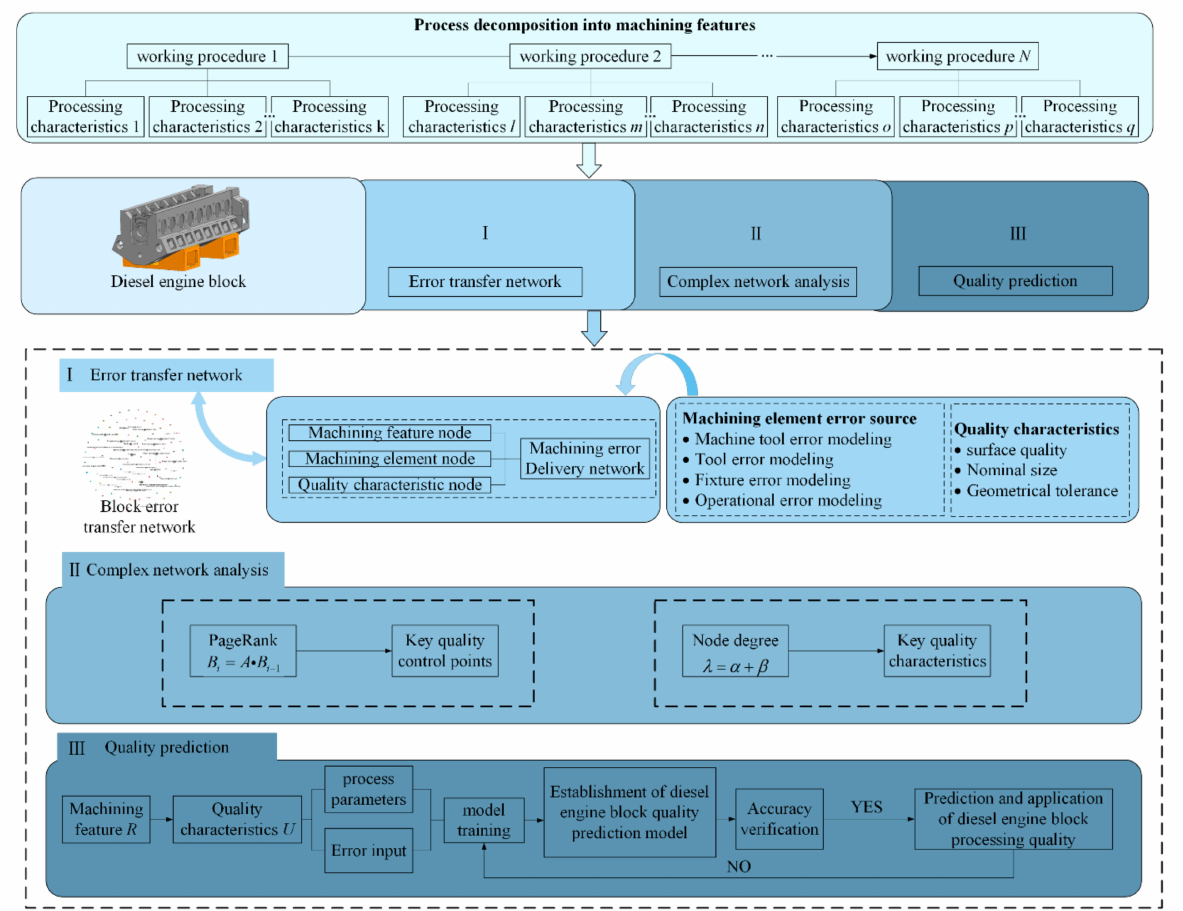
Figure 1. Diesel engine body machining error transfer network establishment and quality predic- tion